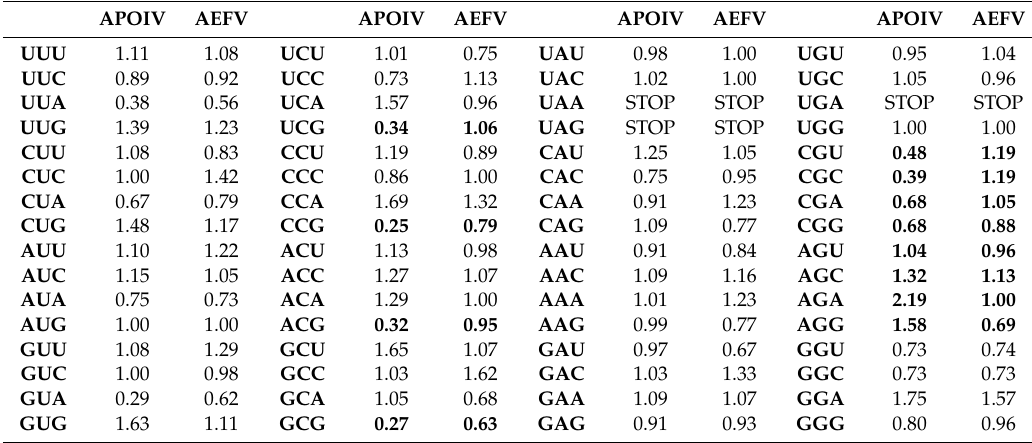
Table 2. RSCU values for each codon, calculated for the APOIV and AEFV coding sequences. Highlighted in bold are the values mentioned in the text. No values have been calculated for stop codons (UAA, UAG, UGA), since only one coding sequence was used for each virus. APOIV AEFV